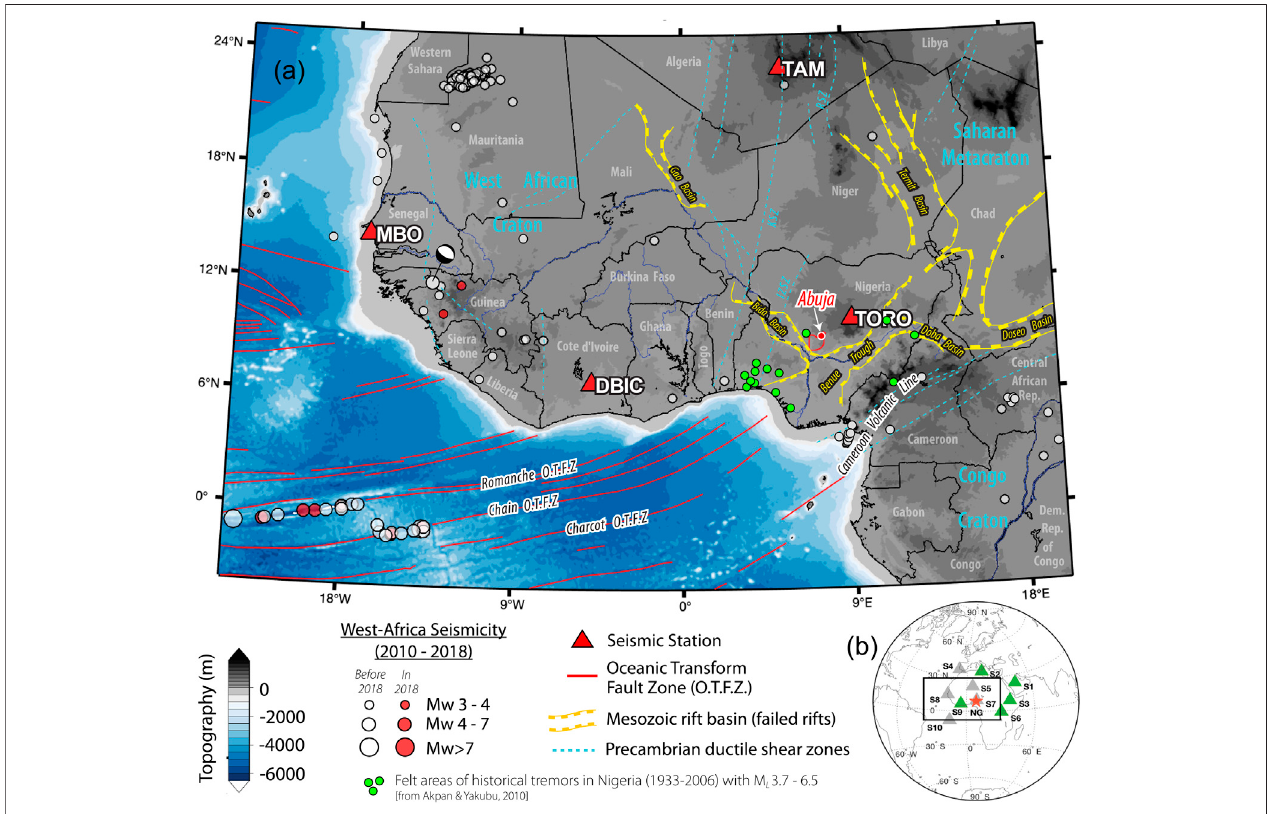
FIGURE 1 | (A) West African seismicity and tectonics, showing the epicenters (circles) for earthquakes in the past decade with M3.0 and greater, ocean fracture zones (red lines), and the seismic network (triangles) available for seismic detection. The 2018 earthquake events (red circles) are outside the Abuja area (red polygon north-east of TORO). OTFZ (cid:1) oceanic transform fault zone (oceanic fracture zone). Tectonic structures are from Pérez-Díaz and Eagles (2014). The Mesosoic failed rifts shown in yellow lines de fi ne the West African Rift System. (B) Final selection of fi ve stations (green triangle) used to search for an earthquake with a hypothetical epicenter (red star) located in Nigeria (NG). Gray stations do not pass the data quality selection criteria. Note that although TAM (S5) has good quality data, it is not used for single station detection since it only has one horizontal channel operating during the time of interest.